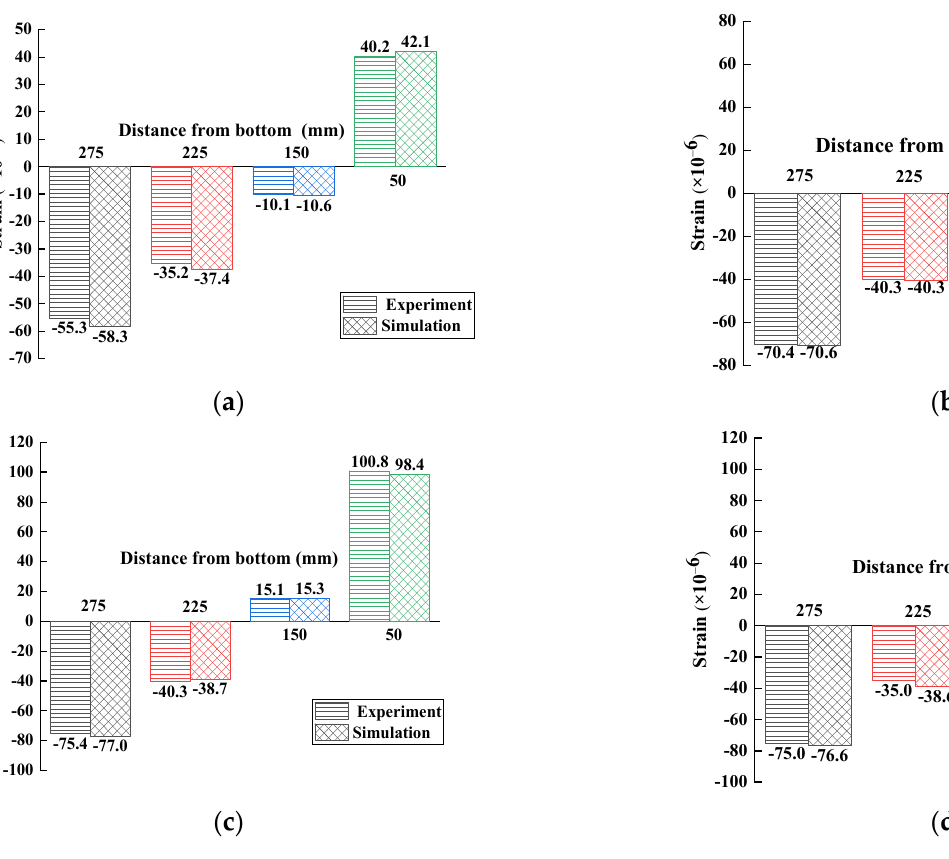
Figure 13. Comparing the elastic strain in the midspan section of the composite beams: ( a ) F-0%-100-80-10; ( b ) F-2%-100-80-10; ( c ) F-10%-100-80-10; and ( d ) F-60%-100-80-10.